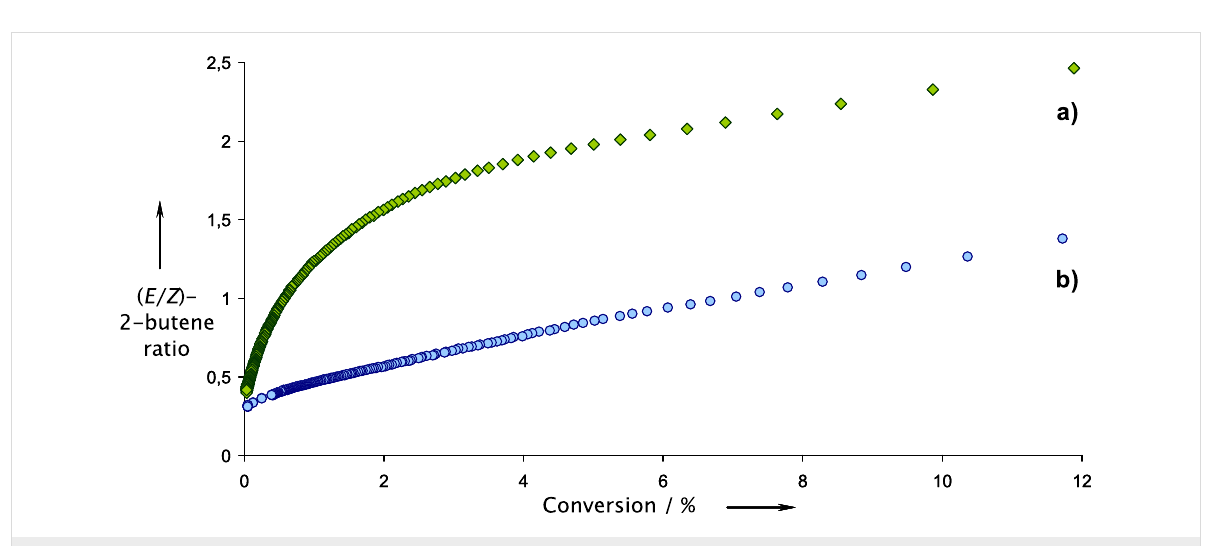
Figure 1: ( E / Z ) ratio as a function of conversion. a) MeReO 3 supported on alumina and b) MeReO 3 supported on alumina modified by trimethylsilyl functionalities.